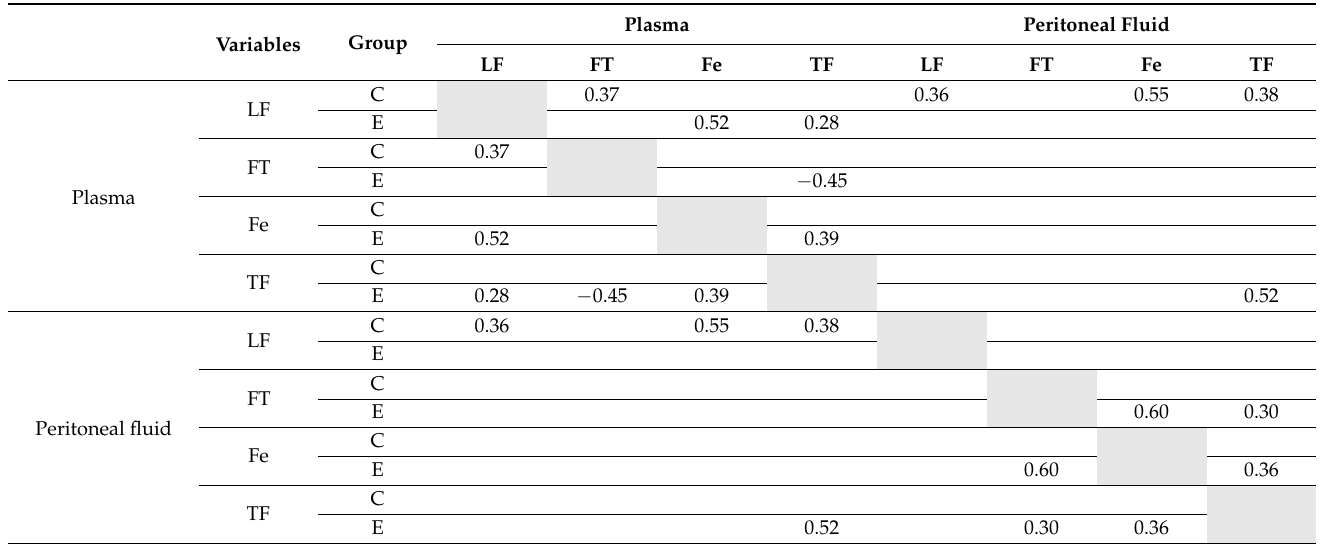
Table 4. Spearman’s rank correlations for lactoferrin (LF), ferritin (FT), iron (Fe) and transferrin (TF) for plasma and peritoneal fluid in groups with (E, n = 57) and without (C, n = 33) endometriosis only statistically significant coefficients